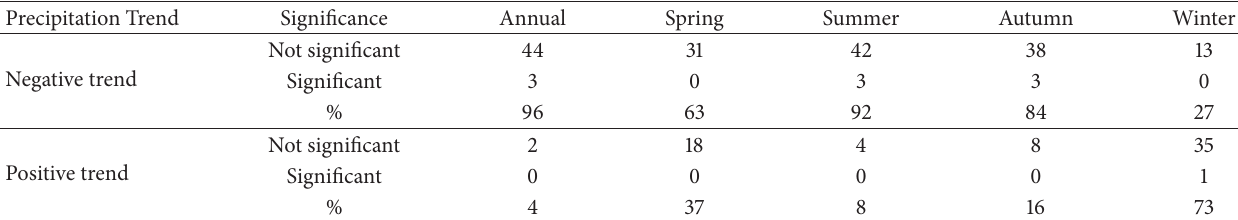
Table 1: Number of meteorological stations with significant trends detected by the Mann-Kendall test for the annual and seasonal precipitation series over the period 1960–2006 in Liaoning,